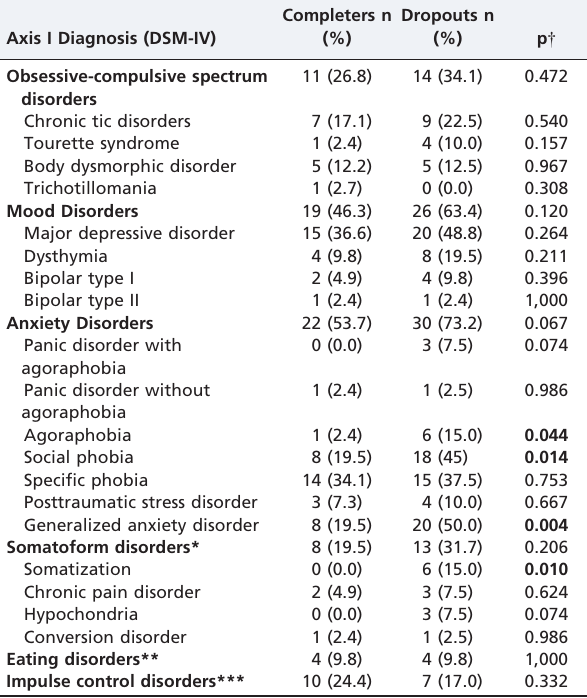
Table II - Psychiatric comorbidities. Table III - Logistic regression model with